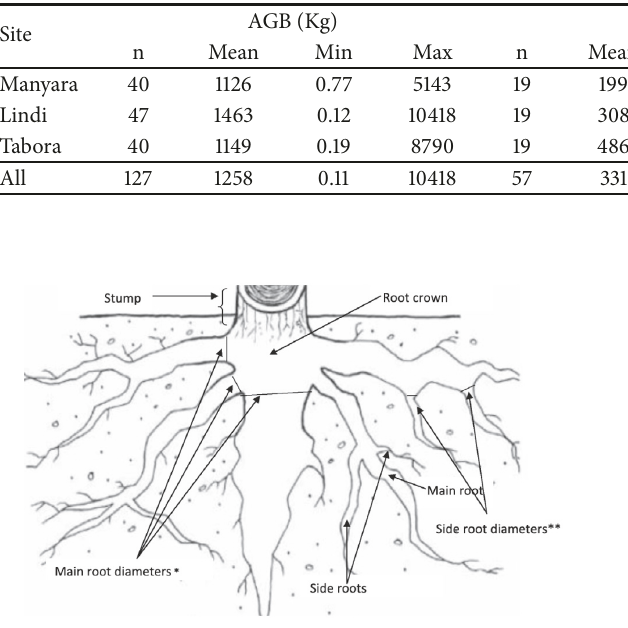
Table 3: Descriptive statistics of volume, above- and belowground biomass.